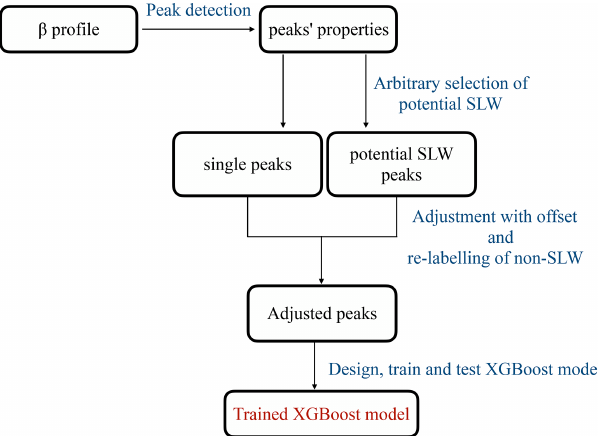
Figure 2. The pre-processing stage in our new algorithm, e.g. G22_Davis: data preparation, model development, training, and